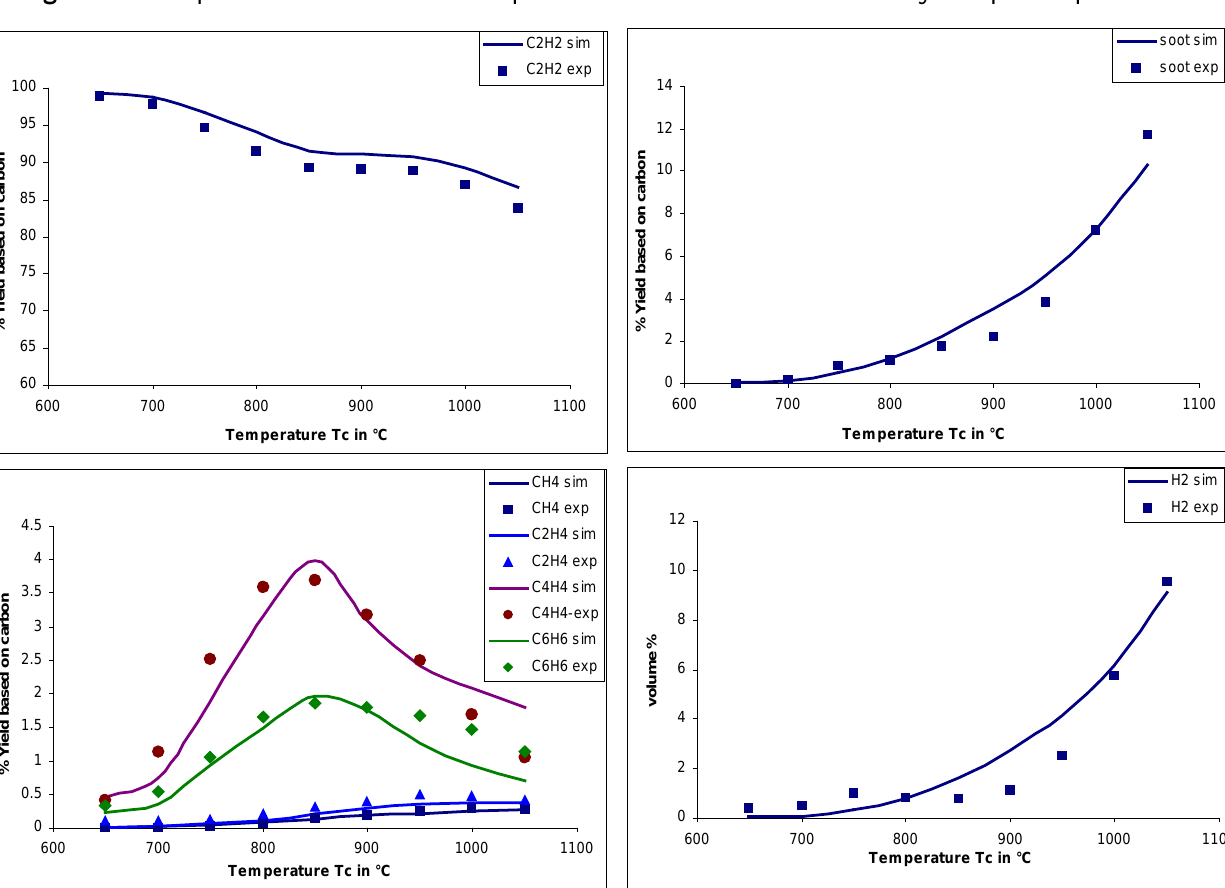
Figure 4. Comparison of simulated vs experimental results at 10 mbar acetylene partial